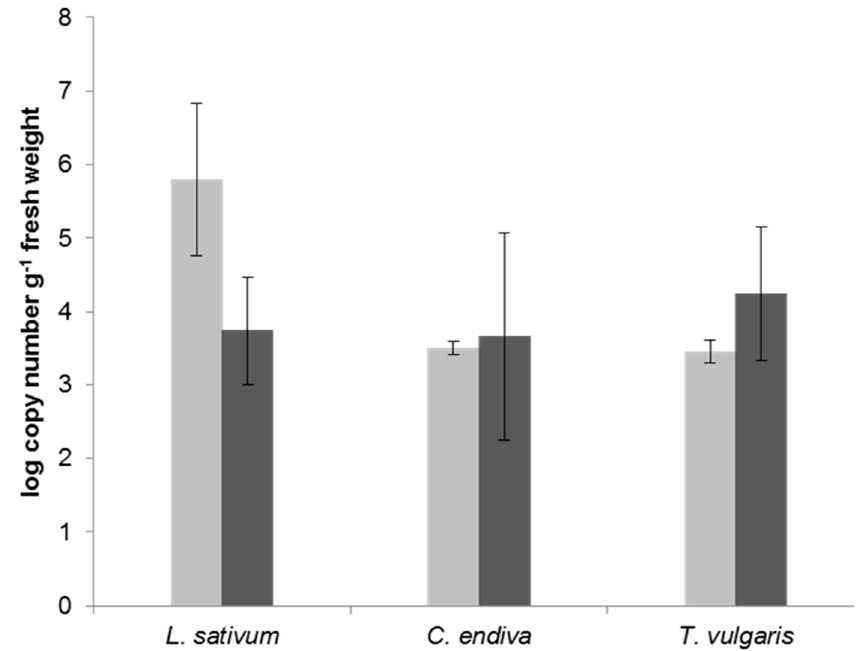
Figure 1. Abundance of bifidobacteria (log 10 copy number per gram fresh weight) in the phyllosphere of three plant species determined via qPCR. Shown are mean values of five plants for the first (light gray bars) and second (dark gray bars) experiment, with the standard deviation as error bars.